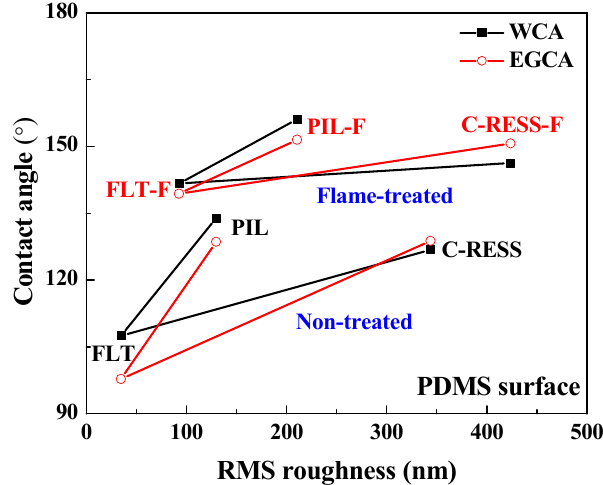
Figure 11. The effects of surface roughness of various PDMS patterns on water contact angle (WCA) and ethylene glycol contact angle (EGCA).